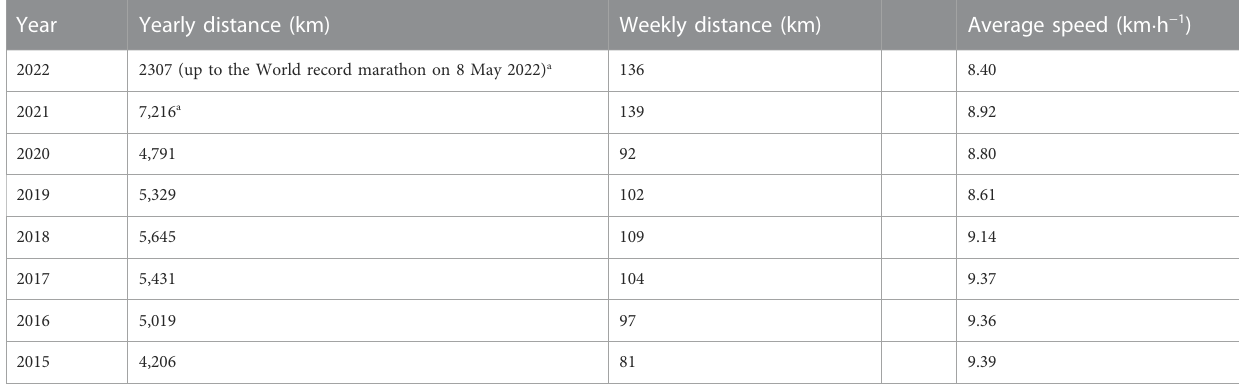
TABLE 1 Training volume per year obtained from